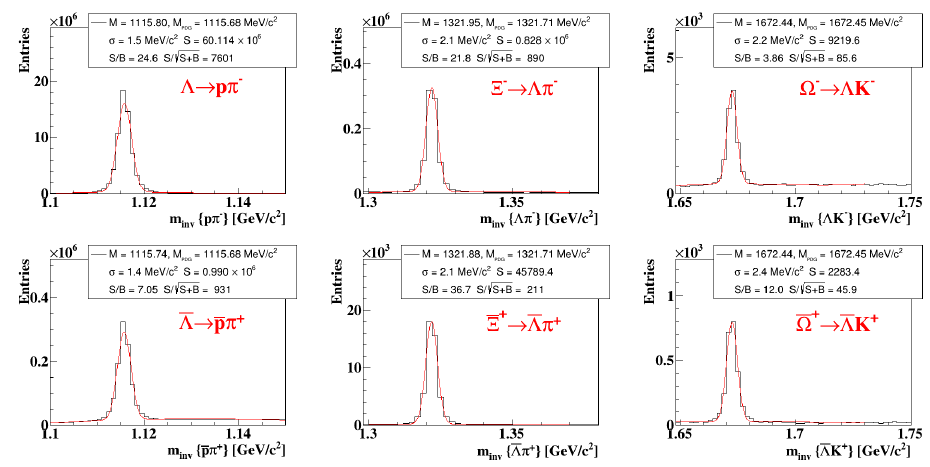
Figure 2. With express calibration and production we observe in real time all hyperons with high significance and S / B ratio (140M AuAu events at 7.7 GeV,